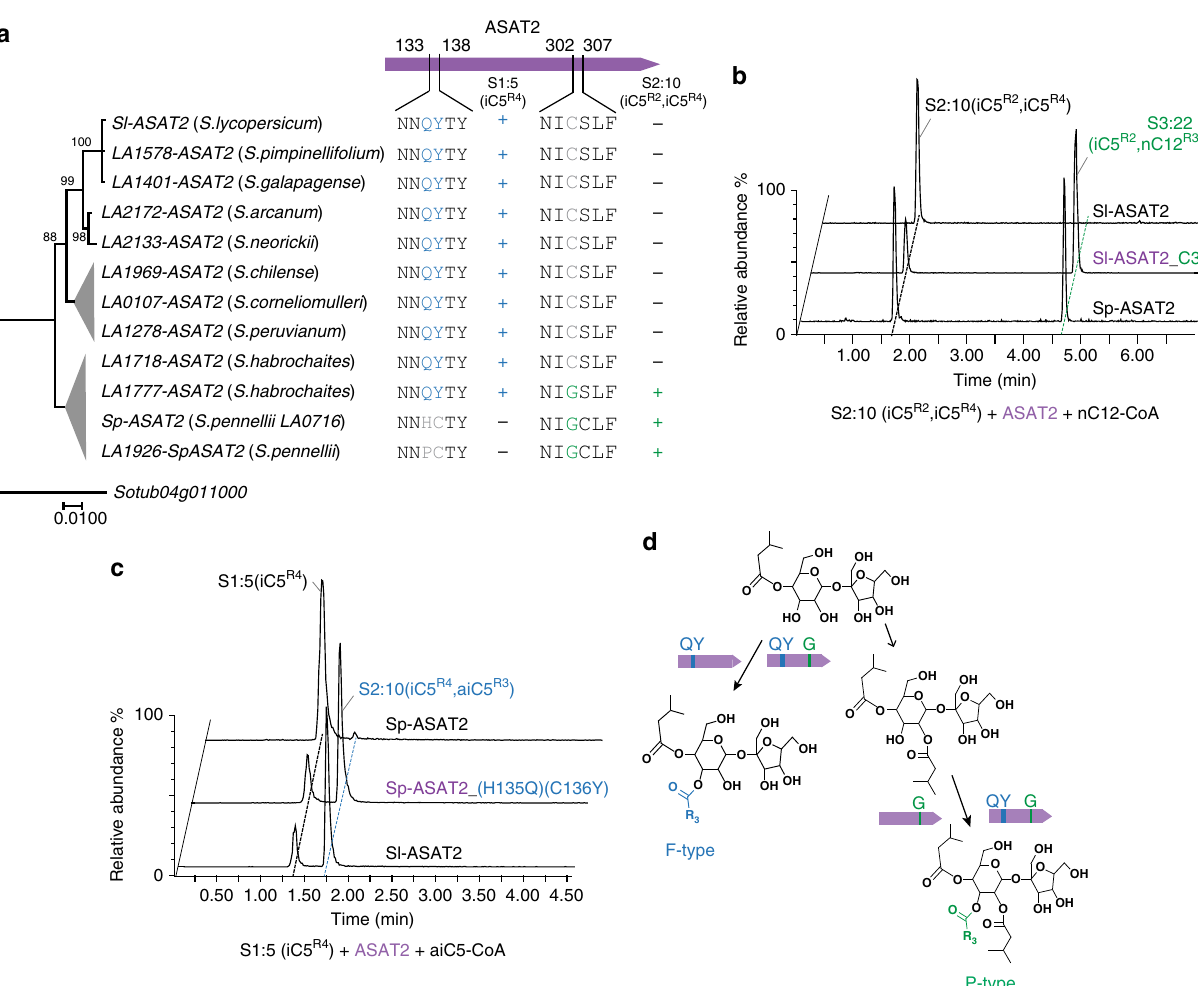
Fig. 4 Identi fi cation of key residues that contribute to switching ASAT2 activities between productions of F- or P-type acylsucroses. a Correlation between ASAT2 enzyme activities and amino acid sequences for various tomato species. The maximum likelihood phylogenetic gene tree was obtained using the nucleotide sequences of ASAT2 variants, with the ASAT2 homolog ( Sotub04g011000 ) in S. tuberosum serving as outgroup. The bootstrap values were obtained with 1000 replicates. The nodes with bootstrap values lower than 70 were collapsed. The ability of different ASAT2 to use acyl acceptor substrates S1:5 (iC5 R4 ) or S2:10 (iC5 R2 , iC5 R4 ) is shown by “ + ” , while “ − ” indicates no detected enzyme activity. Presence of Q 135 Y 136 and G 304 correlate with activity with S1:5 and 2:10 acceptor substrates, respectively. b Results of in vitro assays performed with the site-directed mutant enzymes. Sl-ASAT2 with the residue substitution C304G produced the P-type triacylsucrose product that has the same chromatographic retention time with Sp-ASAT2 ’ s product using S2:10 (iC5 R2 , iC5 R4 ) as the substrate. c Sp-ASAT2 with the dual residue substitutions H135Q and C136Y produced the diacylsucrose product that has the same chromatographic retention time with Sl-ASAT2 ’ s product using S1:5 (iC5 R4 ) as the substrate. d Interpretation of the results of parts b and c , showing the key amino acids associated with F- and P-type ASAT2 enzyme